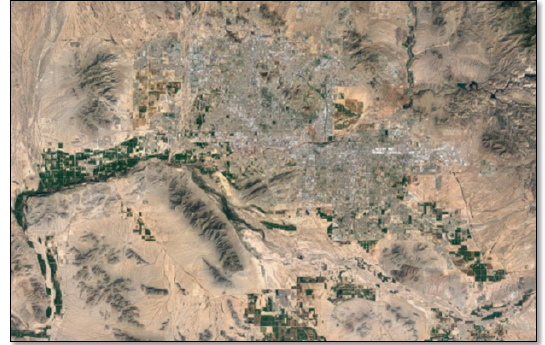
Figure 1: Selected ROI for the Phoenix